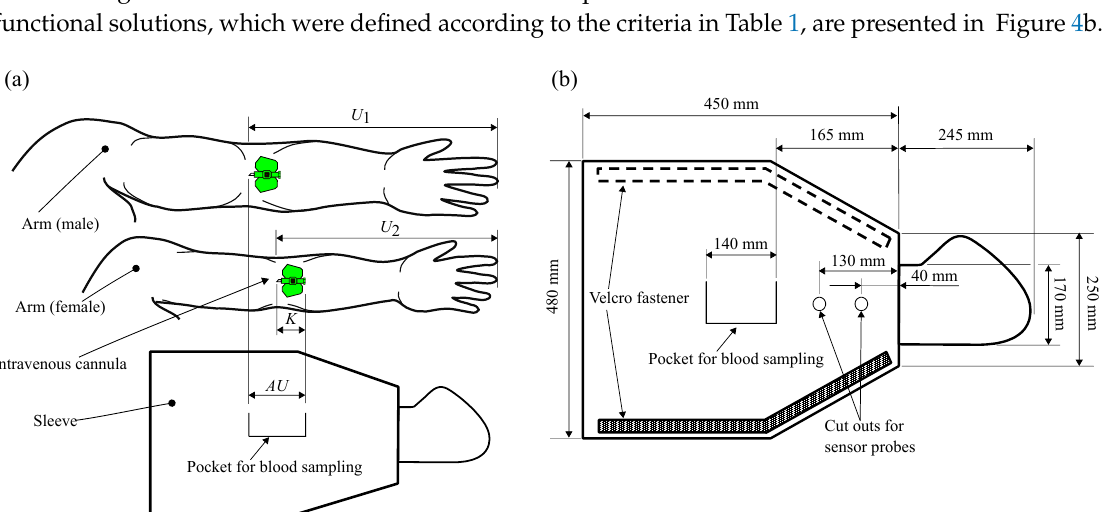
Figure 4. ( a ) Method of dimension definition for the function-integrative sleeve; and ( b ) dimensions and functional